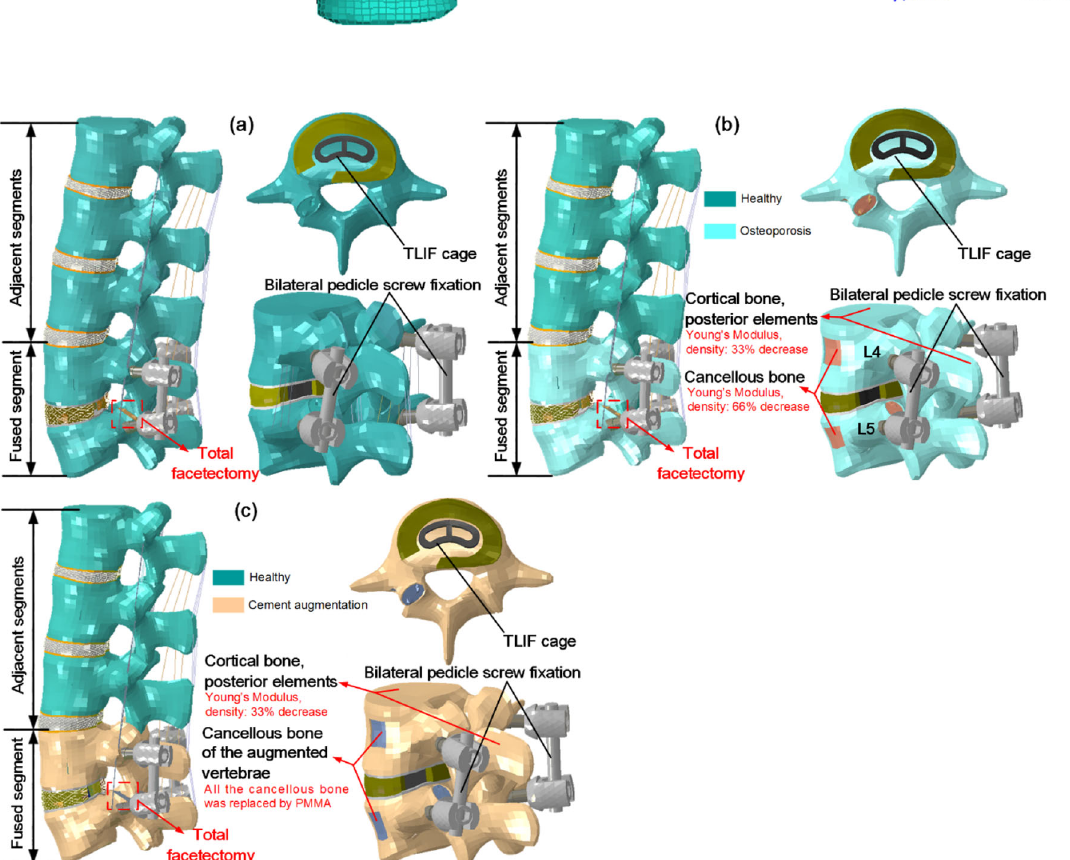
Fig. 2 Finite element models for different conditions. a TLIF model b TLIF model with osteoporotic L4, L5 lumbar vertebrae c PMMA cement augmented TLIF